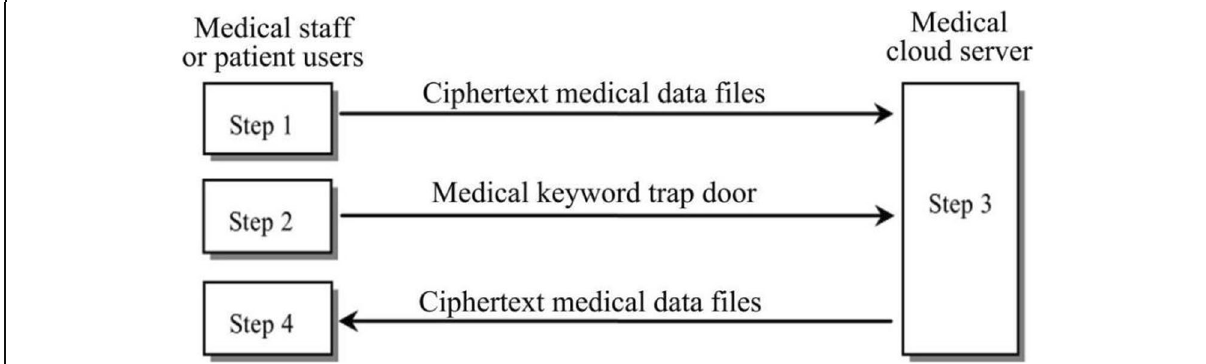
Fig. 4 Searchable encryption process